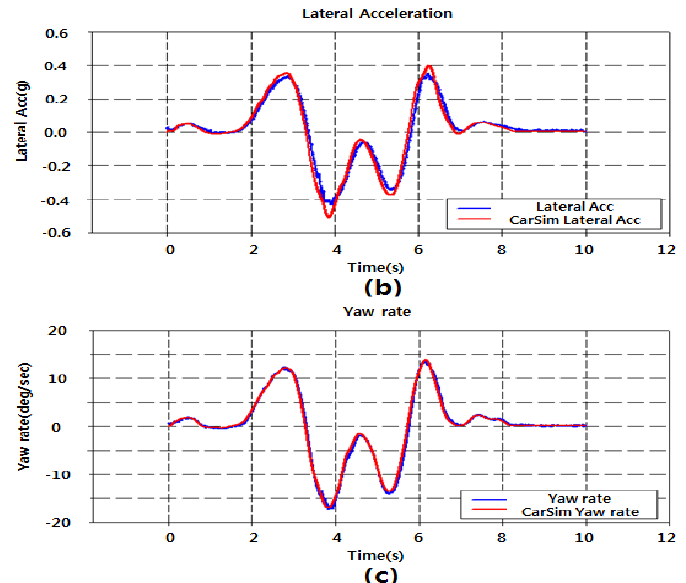
Figure 6. Comparison with experiment and simulation results under double lane change test condition: ( a ) roll angle; ( b ) lateral acceleration; ( c ) yaw rate.